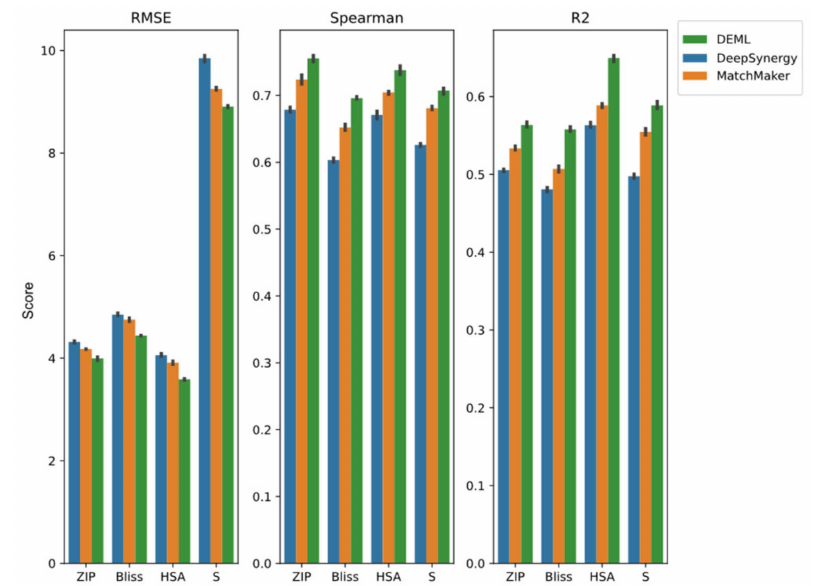
Figure 4. Prediction performance of DEML and single-task comparison algorithms in other four regression prediction tasks. The error bar represents 95% confidence interval of five-fold